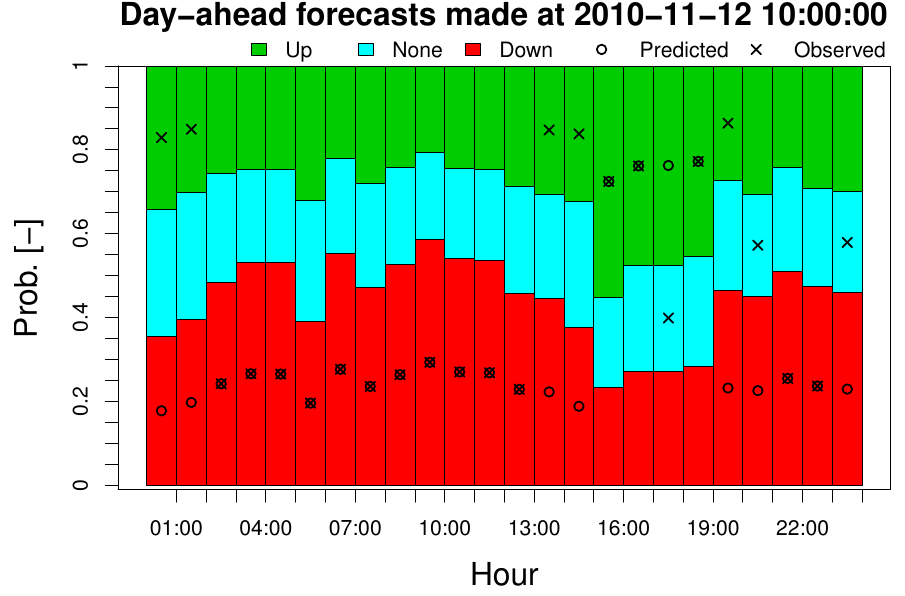
Figure 5. Stacked bar plot showing the posterior imbalance sign probabilities estimated at 10:00 on 12 November 2010, for November 13. The most likely imbalance sign and the observed one are